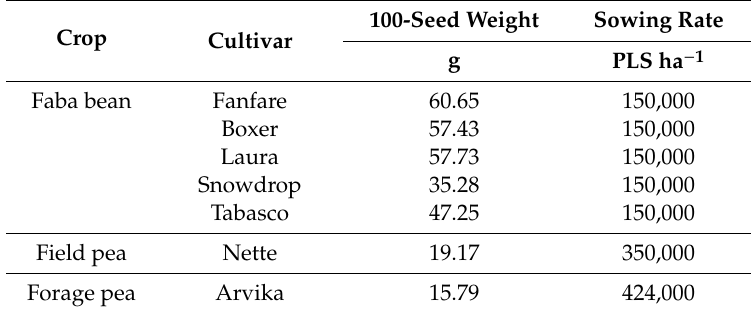
Table 2. Seed weight and sowing rate of cover crop cultivars sown after wheat harvest in Prosper and Hickson, ND, in 2017 and